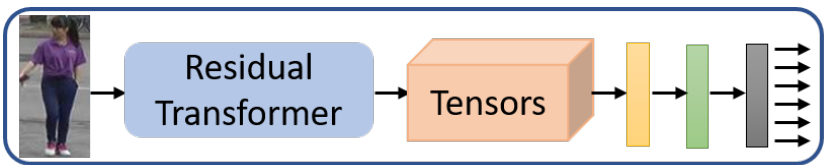
Figure 6. The network structure of the PCB Transformer, which employs the Residual Transformer as a